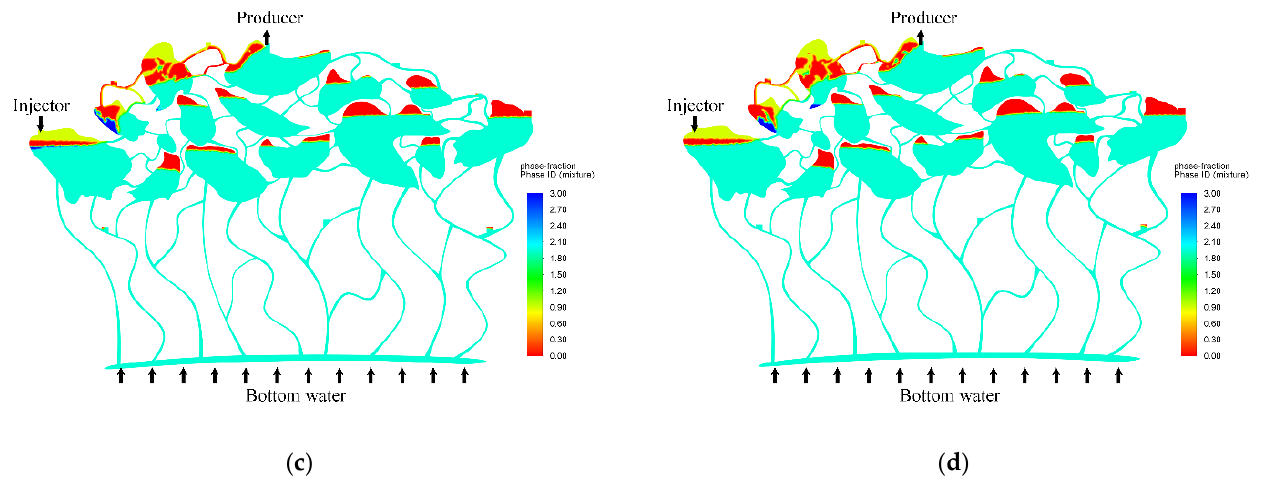
Figure 9. Fluid distribution in nitrogen injection with different flow rates: ( a ) initial time of gas flooding; ( b ) 20,000 m 3 /d; ( c ) 50,000 m 3 /d; ( d ) 80,000 m 3 /d.